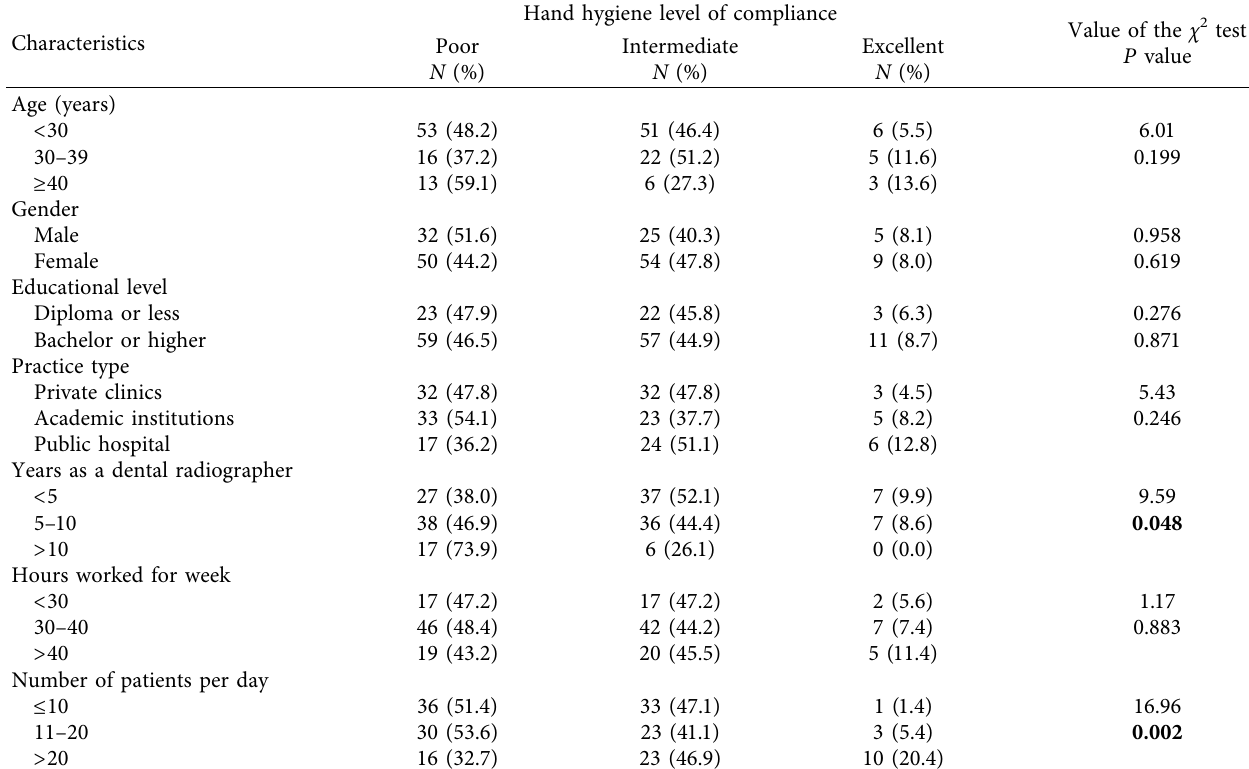
Table 4: The level of compliance with HH practices ( N � 175).